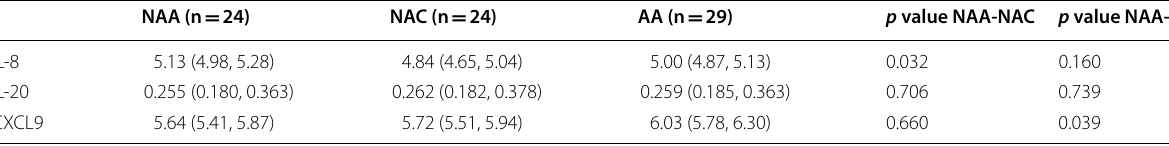
Table 4 Group comparisons for the proteins significantly correlating with MMP-1 (concentrations in NPX)